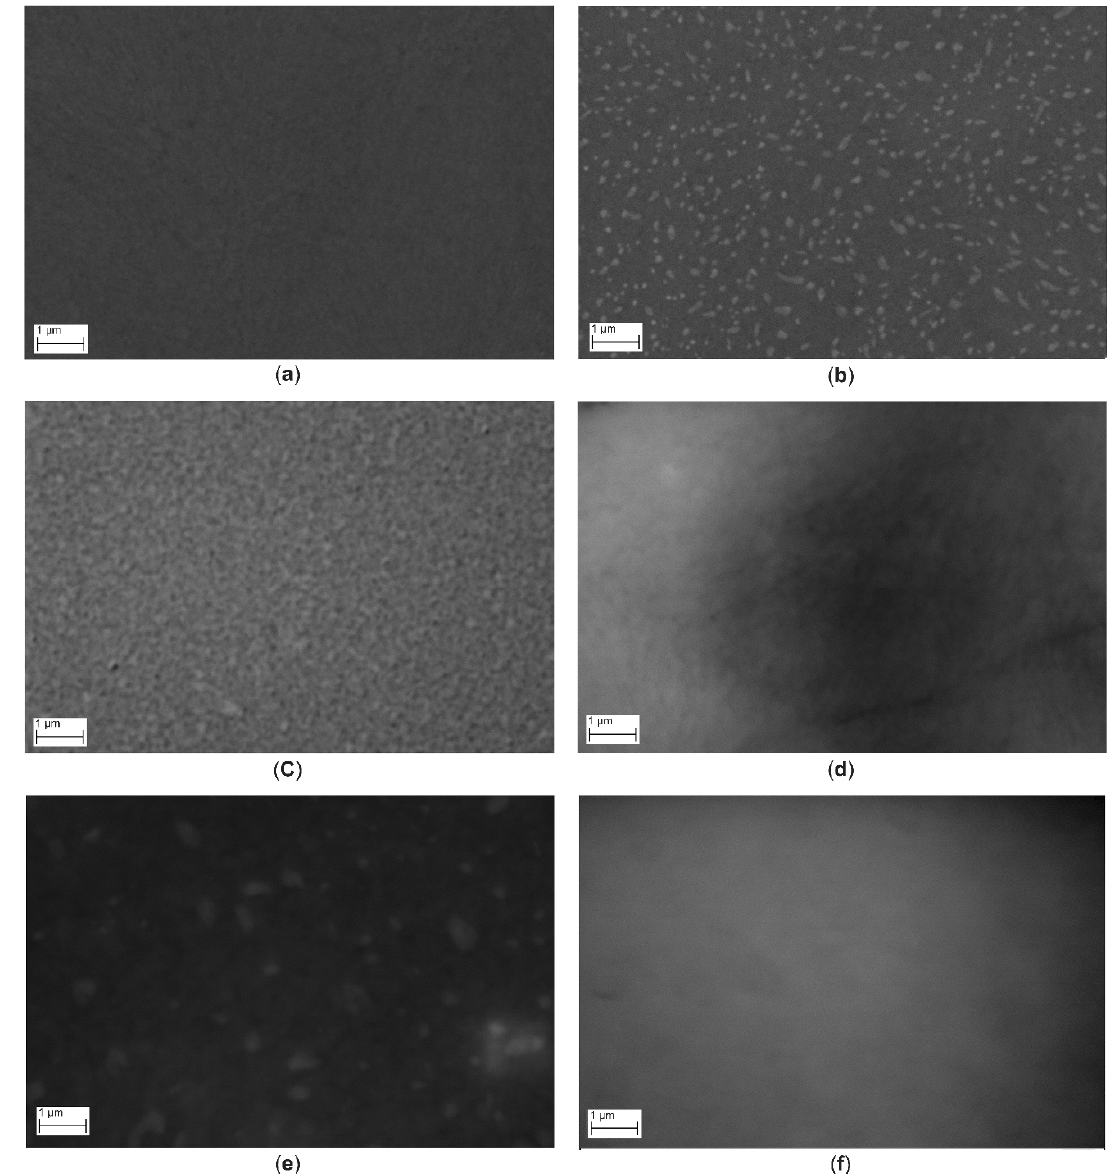
Figure 1. Microphotograph of ( a ) S1 , ( b ) S2 and ( c ) S3 in glass substrate, ( d ) S1 , ( e ) S2 and ( f ) S3 in Figure 1 polyethylene terephthalate (PET) substrate at 10000 ×